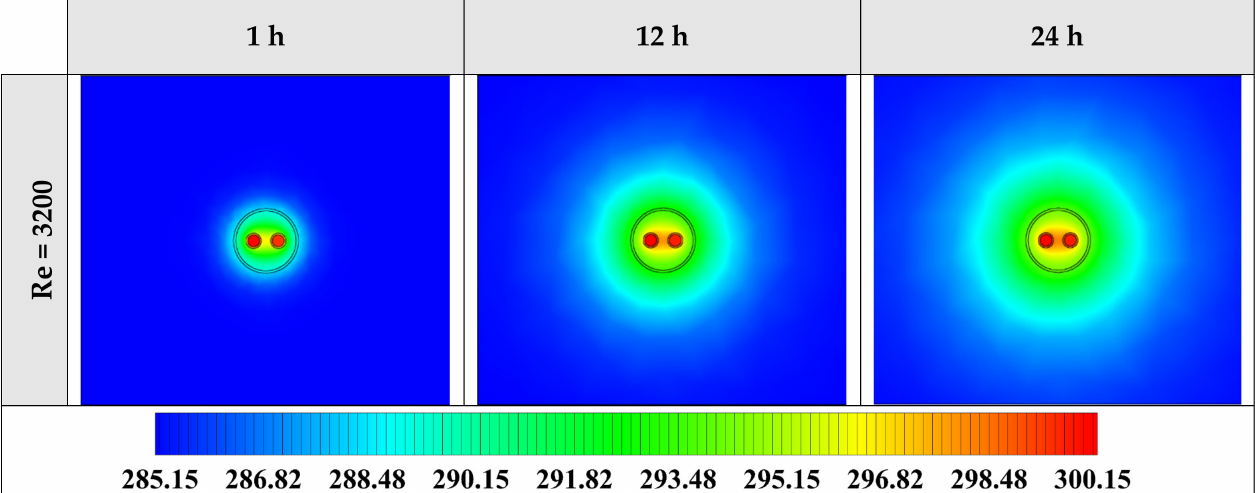
Figure 21. Two-dimensional (2D) contours of the temperature distribution of the BHE at various hours of operating using Ag–MgO/water hybrid nanofluid at Re = 3200 and φ = 0.10 (Top view at Z =